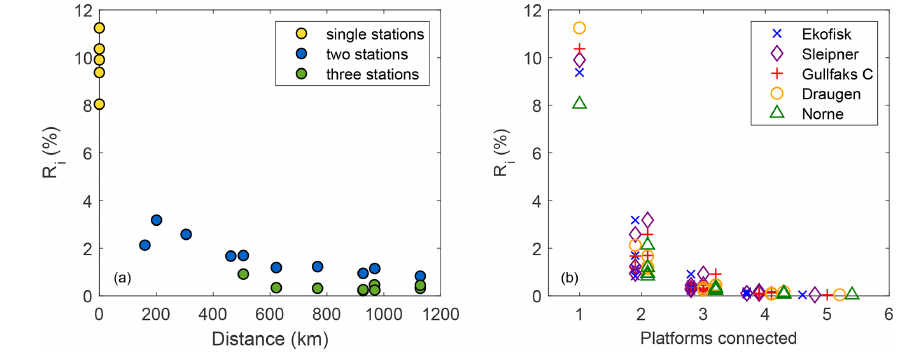
Figure 9. Panel (a) demonstrates how the risk ( R i ) changes with distance between the connected sites. Panel (b) illustrates how the risk ( R i ) changes as the array size of connected sites increases from zero (single sites) to five (all sites connected).